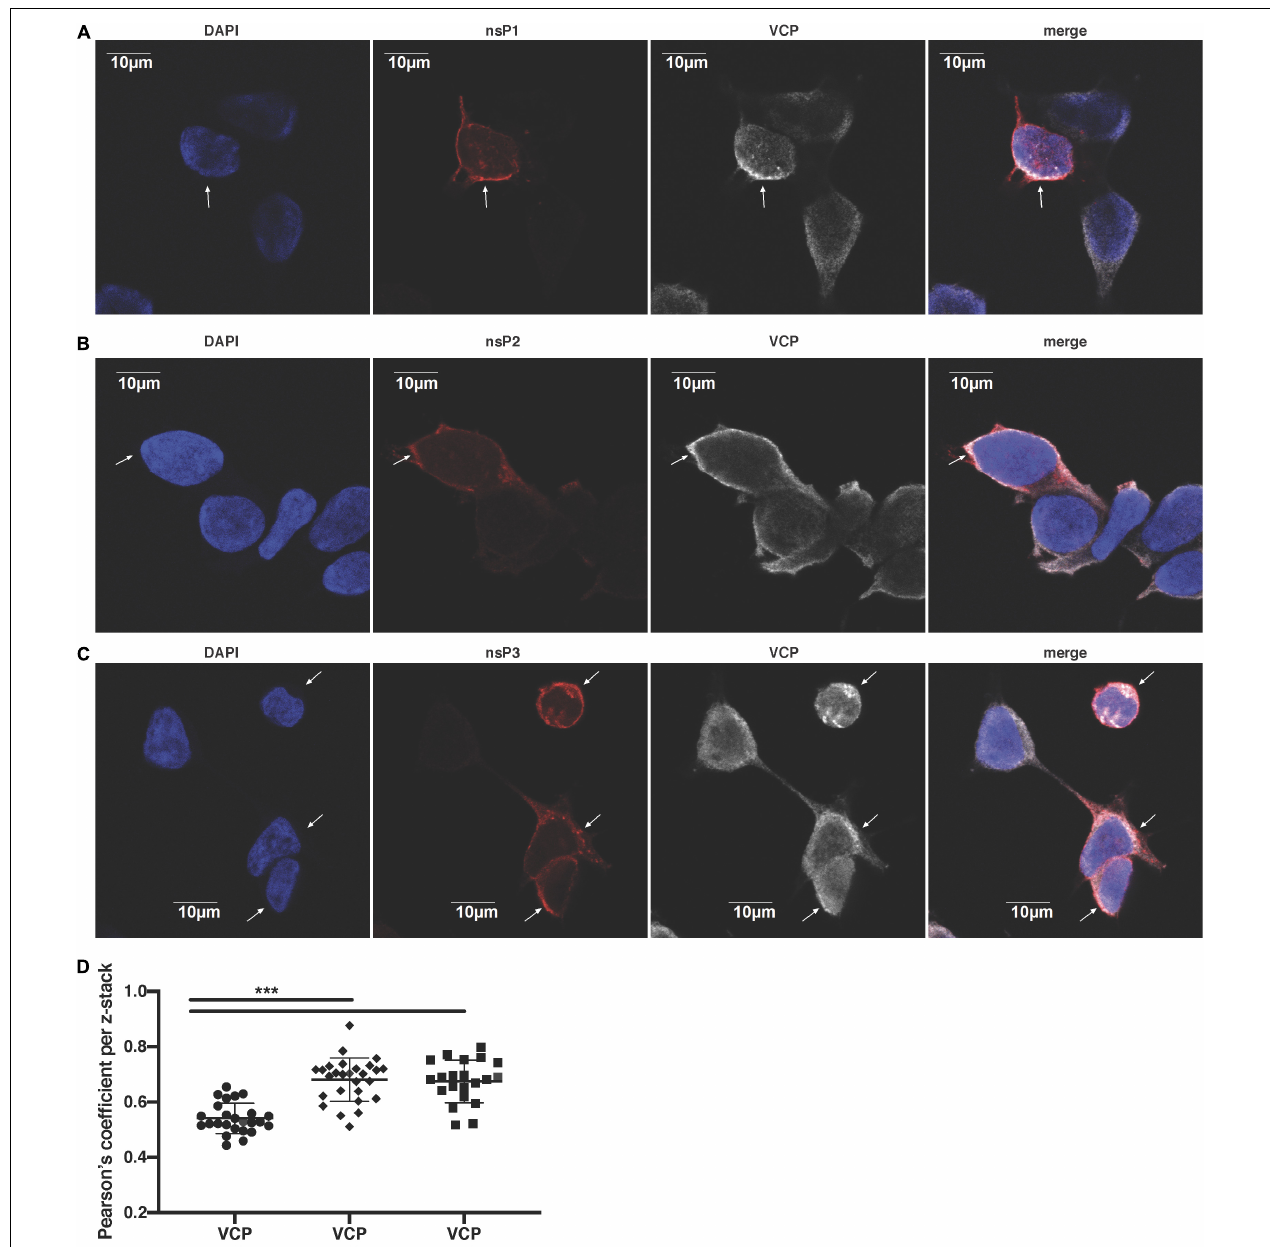
FIGURE 5 | VCP localizes with CHIKV replicase components. HEK 293T cells were infected at an moi of 10, 2 hpi cells were then plated in Ibidi µ -wells microscopy chambers; 5 hours post-plating, cells were fixed, permeabilized, and co-stained in duplicate for VCP with nsP1, nsP2, or nsP3 as indicated on the figure. Cells were counterstained with DAPI before confocal acquisition of z-stacks. (A) Representative focal plane of VCP with nsP1. (B) Representative focal plane of VCP with nsP2. (C) Representative focal plane of VCP with nsP3. (D) Pearson correlation coefficient of colocalization of VCP with the respective nsPs in each z-stack analyzed with Imaris software. Results are representative of two independent experiments performed in duplicate. White arrows indicate infected cells. Correlation coefficient were analyzed by Mann–Whitney non-parametric two-tailed test; ∗∗∗ p <